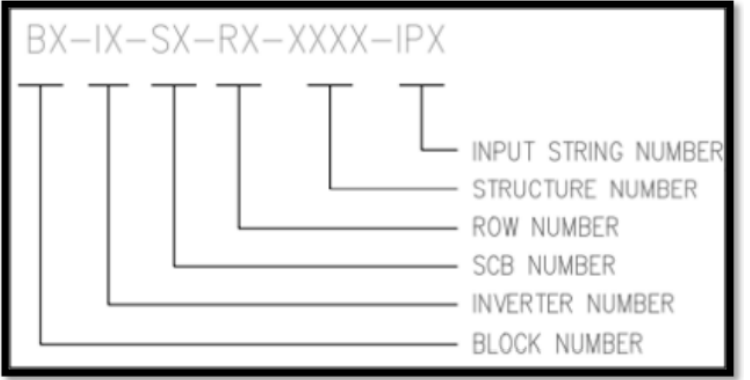
Figure 4. Table nomenclature. The six di ff erent fi elds that need to be fi lled in order to quote each table uniquely according to the required guidelines.